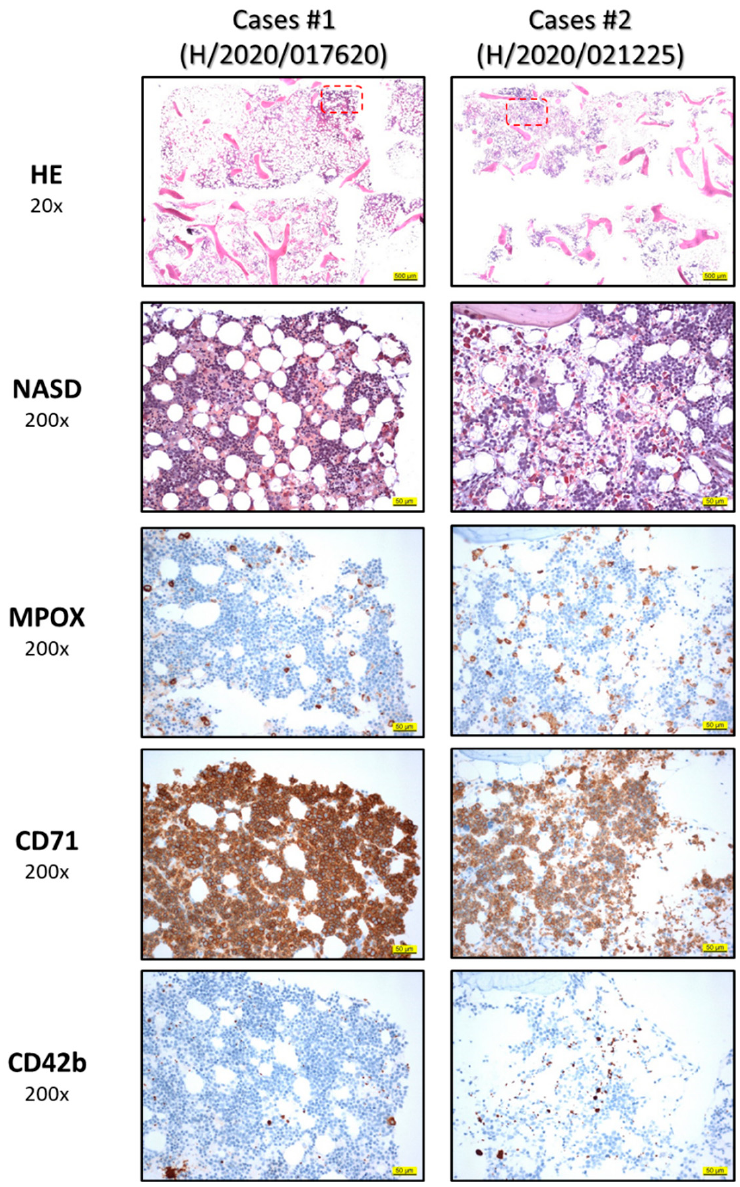
Figure 2. Patient A: The HE-staining in combination with NASD-reaction of the bone marrow demonstrated a slightly increased cellularity with increased erythropoesis (CD71) as well as re- duced granulopoiese (MPOX) and megakaryopoisis (CD42b). The additional imunhistochemicals (E-Cadherin, CD14 and CD68, not shown) revealed distinct dysplastic changes of the hematopoe- sis. Apart from that, low-grade bone marrow fibrosis with discrete hemosiderin deposition were found (not shown). Patient B: The routine stainings (HE-staining and NASD-reaction) revealed an enhanced cellularity of the hematopoesis in comparison to Patient A. Again, the erythropoiesis (CD71) was clearly increased, whereby the granulopoiesis (MPOX) was decreased with left shift and the megacaryopoeisis (CD42b) was normocellular. Additionally, hemosiderin deposition was increased (not